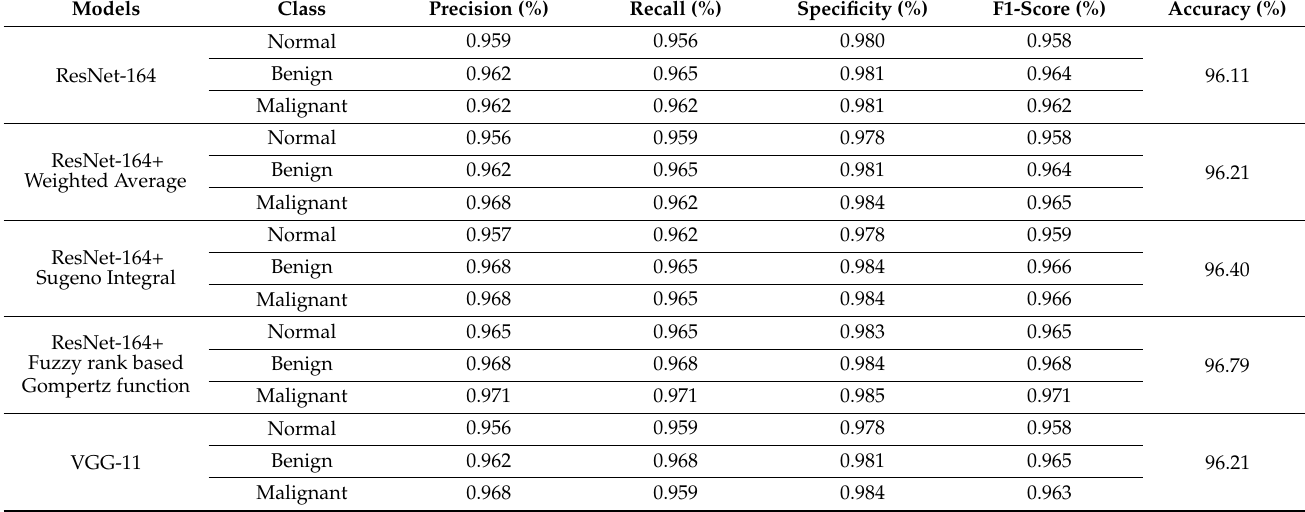
Table 1. Performance indicators for a variety of deep CNN models using fuzzy ensemble approaches based on testing datasets.